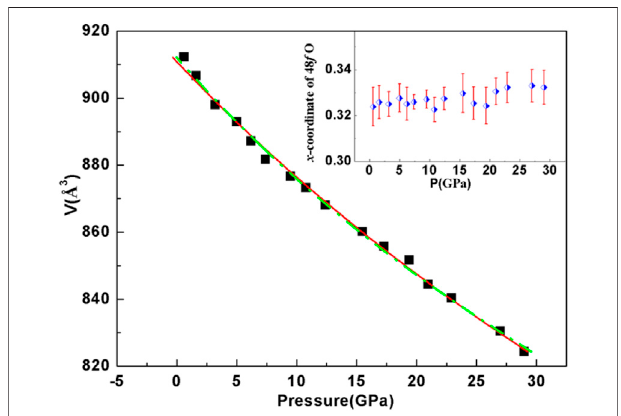
FIGURE 3 | Observed P – V variation fi tted with the third-order Birch – Murnaghan (B – M) equation of state for In 2 Mn 2 O 7 . Birch – Murnaghan EOS fi ts for the data are shown with the dotted line, B (cid:1) 221(6) GPa, B ′ o (cid:1) 5.5(1.2), and solid line, B (cid:1) 240(4) GPa, B ′ o held at 4. The inset shows the pressure dependence of the x parameter for the O 48f